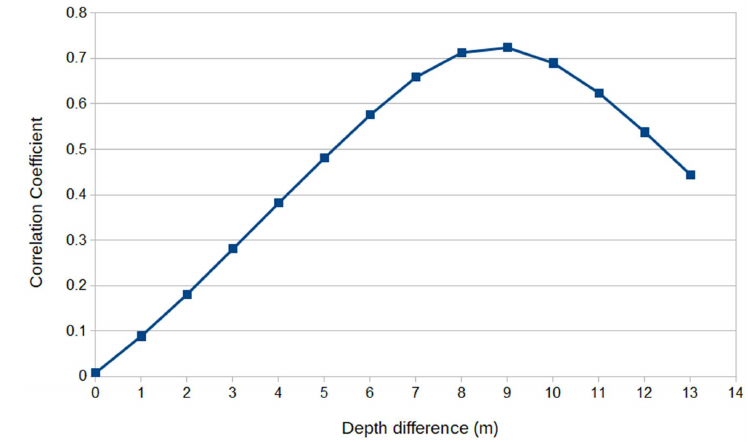
Figure 5. Cross-correlation between day vs. night, using depth (h) as the lag parameter. A depth difference of dh = ~9 m produces the maximum correlation between day and night fish density distributions.